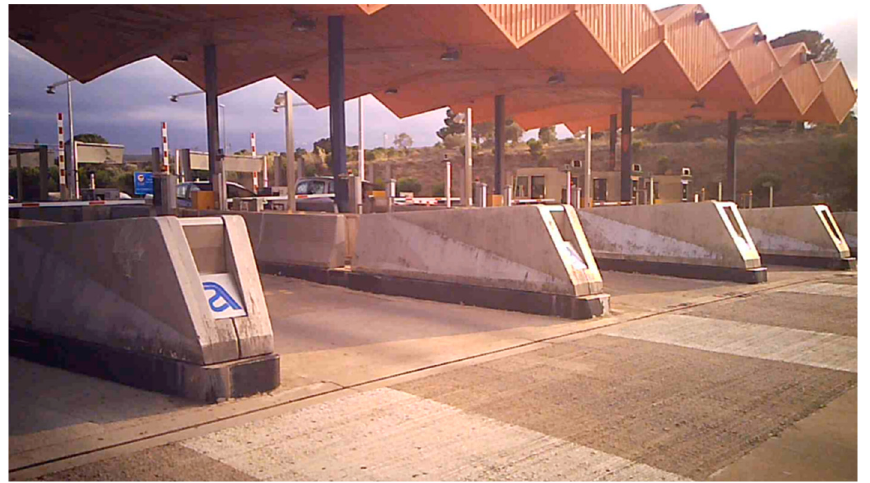
Figure 2. The AP-7 tollbooth where the Guardia Civil carries out most of the police checks analysed for this research (authors’ data collection).